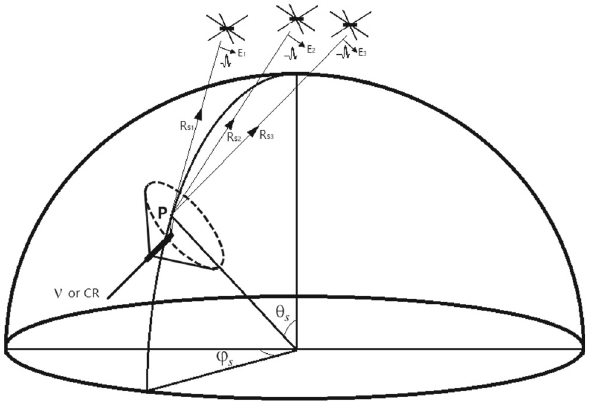
Fig. 10 Scheme of Askaryan pulse detections in the lunar soil with three antennas onboard micro-satellites